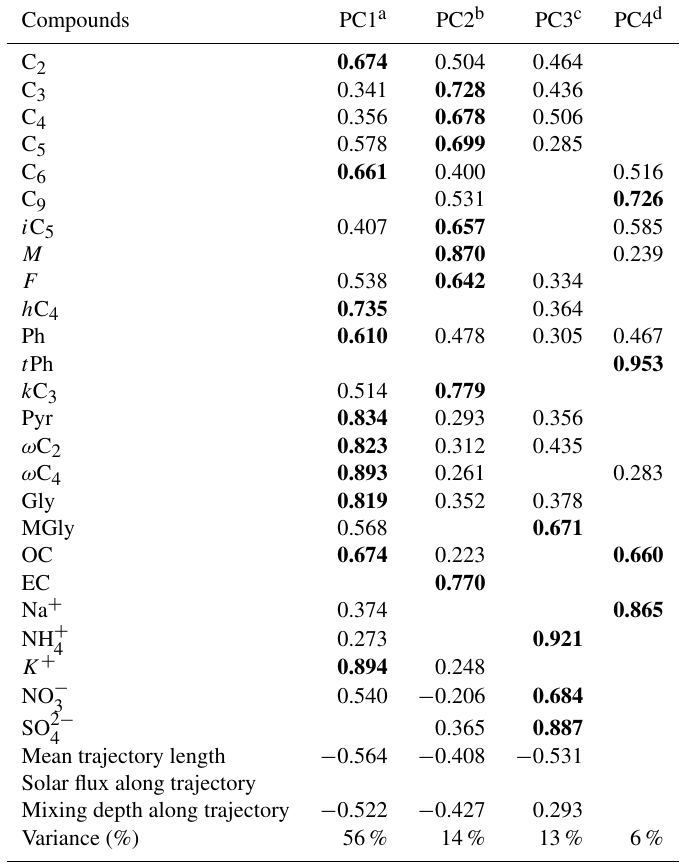
Table 4. PCA factor loadings for nighttime DCRCs, OC, EC and inorganic ions as well as mean trajectory length, solar flux along trajectory and mixing depth along